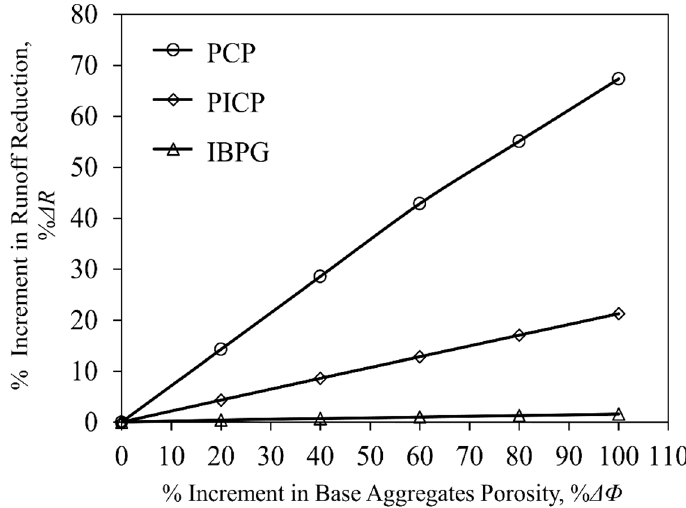
Figure 7. Plot demonstrating the increase in runo ff reduction behavior as a function of change in the